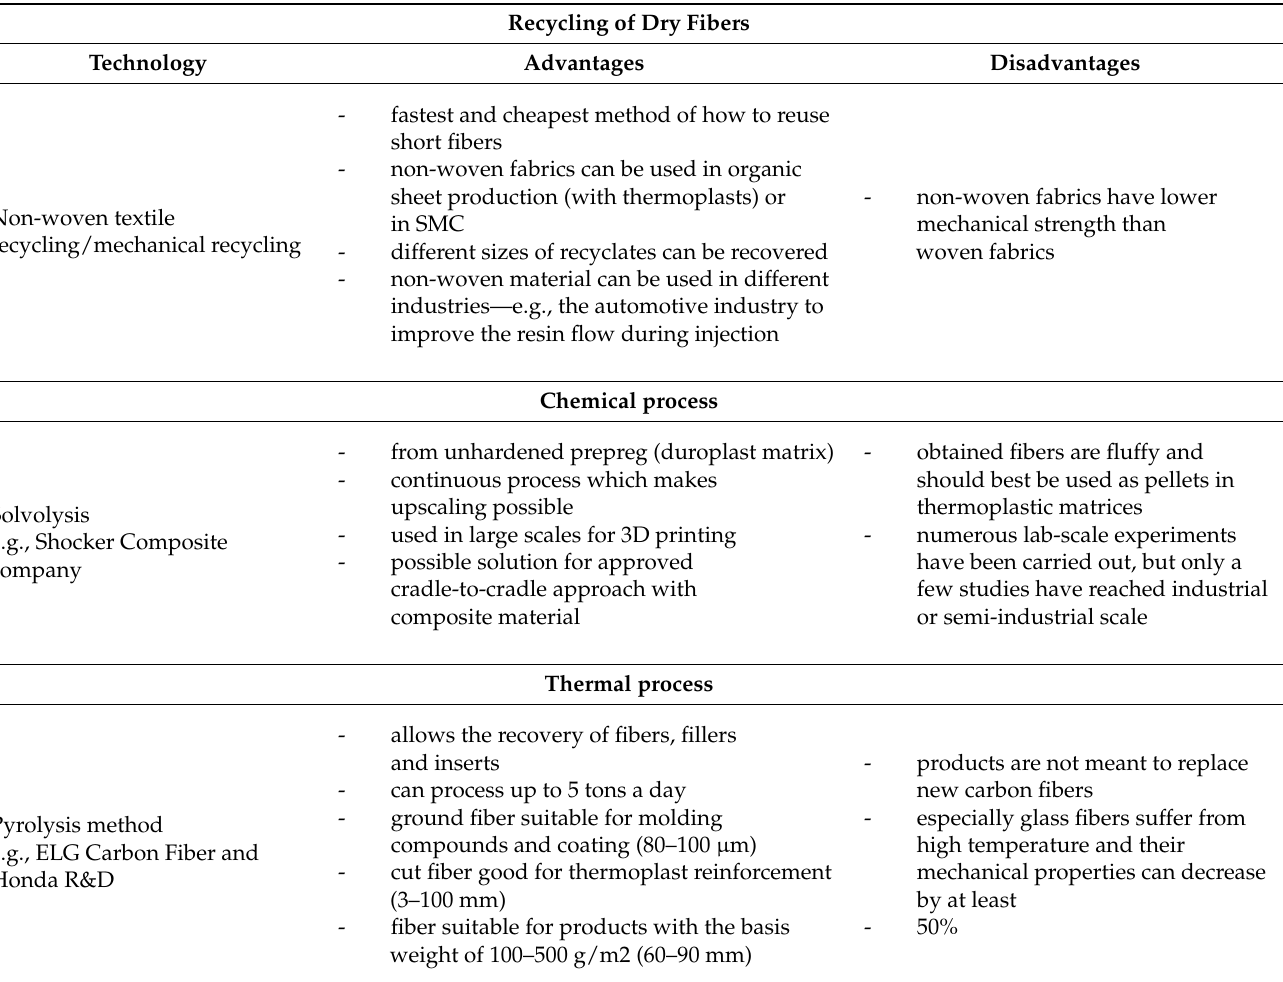
Table 5. Summary of carbin fiber (CF) recovery